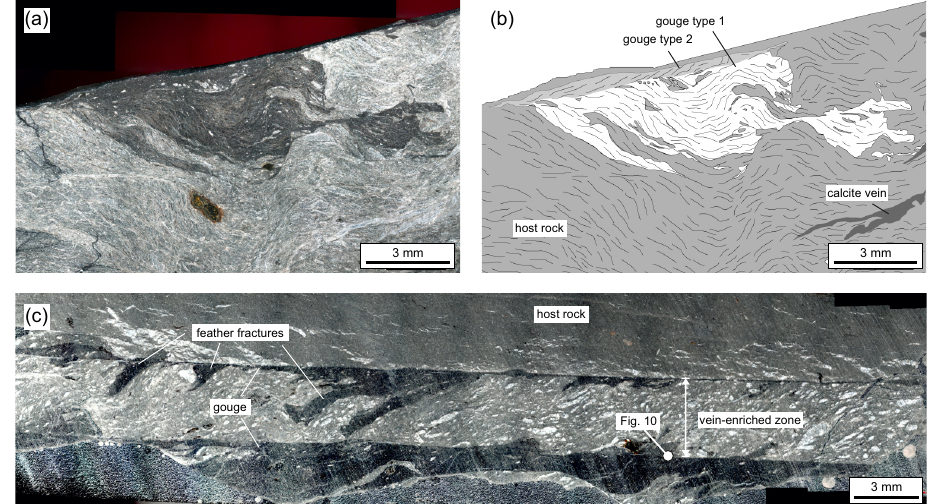
Figure 5. Injection-like textures of gouge into scaly wall rock. (a) Reflected light micrograph and (b) sketch of sample V06. (c) Reflected light micrograph of sample A1. Note that the feather fractures are synthetic; the shape of wall rock clasts in panel (a) follow the gouge foliation. A band of gouge type 2 is visible at the upper border of the sample in panel (a) . See text for details.